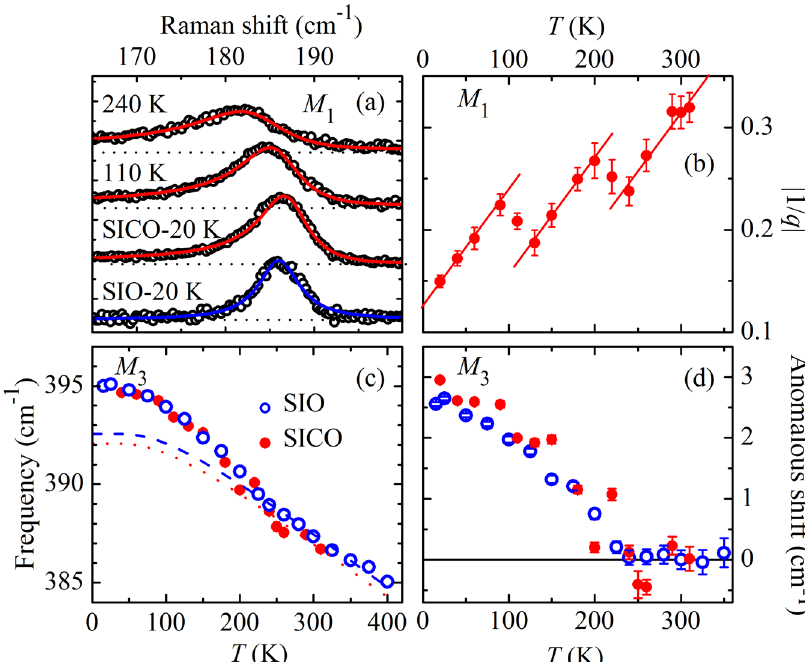
Fig. 5 Temperature-dependent Raman scattering. a Raman spectrum of Sr 2 Ir 0.95 Co 0.05 O 4 (SICO) at selected temperatures and Sr 2 IrO 4 (SIO) at 20 K in the vicinity of the M 1 peak (symbols, see also Fig. 2c). The solid lines are fi ts to an asymmetric Fano lineshape for SICO and a symmetric Lorentzian lineshape for SIO. Data were vertically translated for clarity. The horizontal dotted lines represent the baseline for each spectrum. b Modulus of the Fano asymmetry parameter ∣ 1/ q ∣ of the M 1 peak of SICO. The straight lines with equal angular coef fi cients are guides to the eye. c Frequency of the M 3 mode of SIO (open circles) and SICO (closed circles). The dashed and dotted lines indicate the expected anharmonic behavior for SIO and SICO, respectively 61 . d Anomalous M 3 phonon shift, de fi ned as the difference between the observed frequencies and the anharmonic contributions shown in ( c ). The errorbars in ( b , d ) are standard deviations extracted from the fi ts, which are smaller than the symbol sizes in ( c